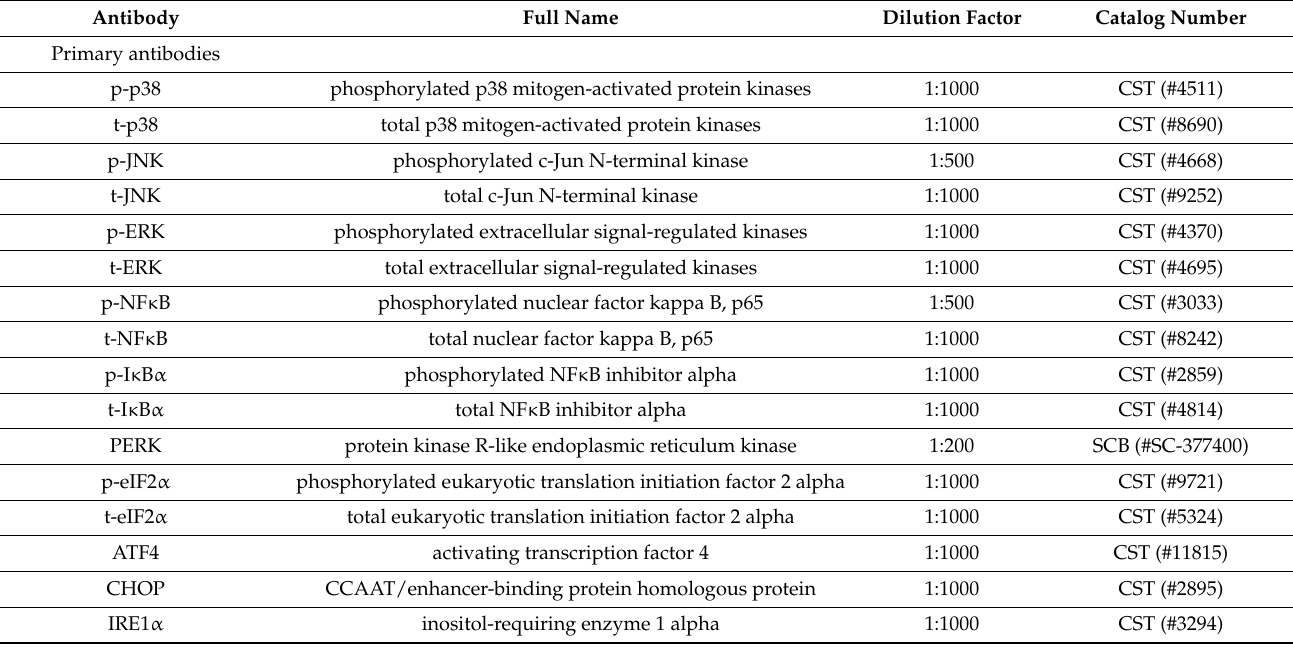
Table 1. Antibodies used for western blot